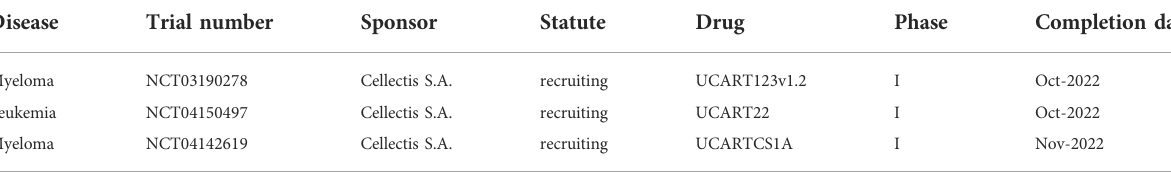
TABLE 3 Summary of TALENs ongoing clinical trials.